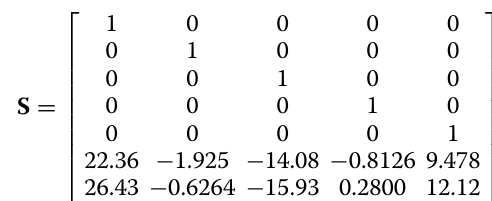
Data from all five pairs of eigenvalues in the modal space are